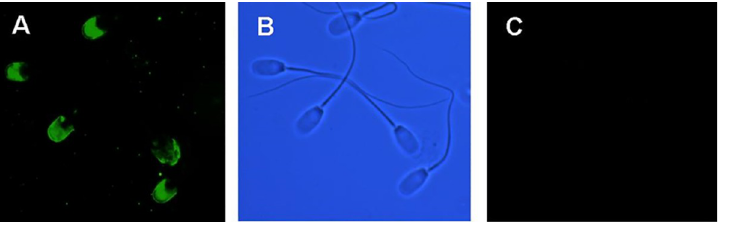
Fig 1. Indirect immunolocalization of SERCA 2 in fixed and permeabilized porcine sperm. Panel A indicates that acrosomal fluorescent labelling is evident when detected with SERCA 2 polyclonal antibody. Panel B shows the phase contrast microscopy photograph of the same field. Panel C shows the non-specific fluorescence of sperm labeled only with secondary fluorescein-conjugated rabbit anti-goat antibody. The experiment was repeated three times and representative photos are shown.